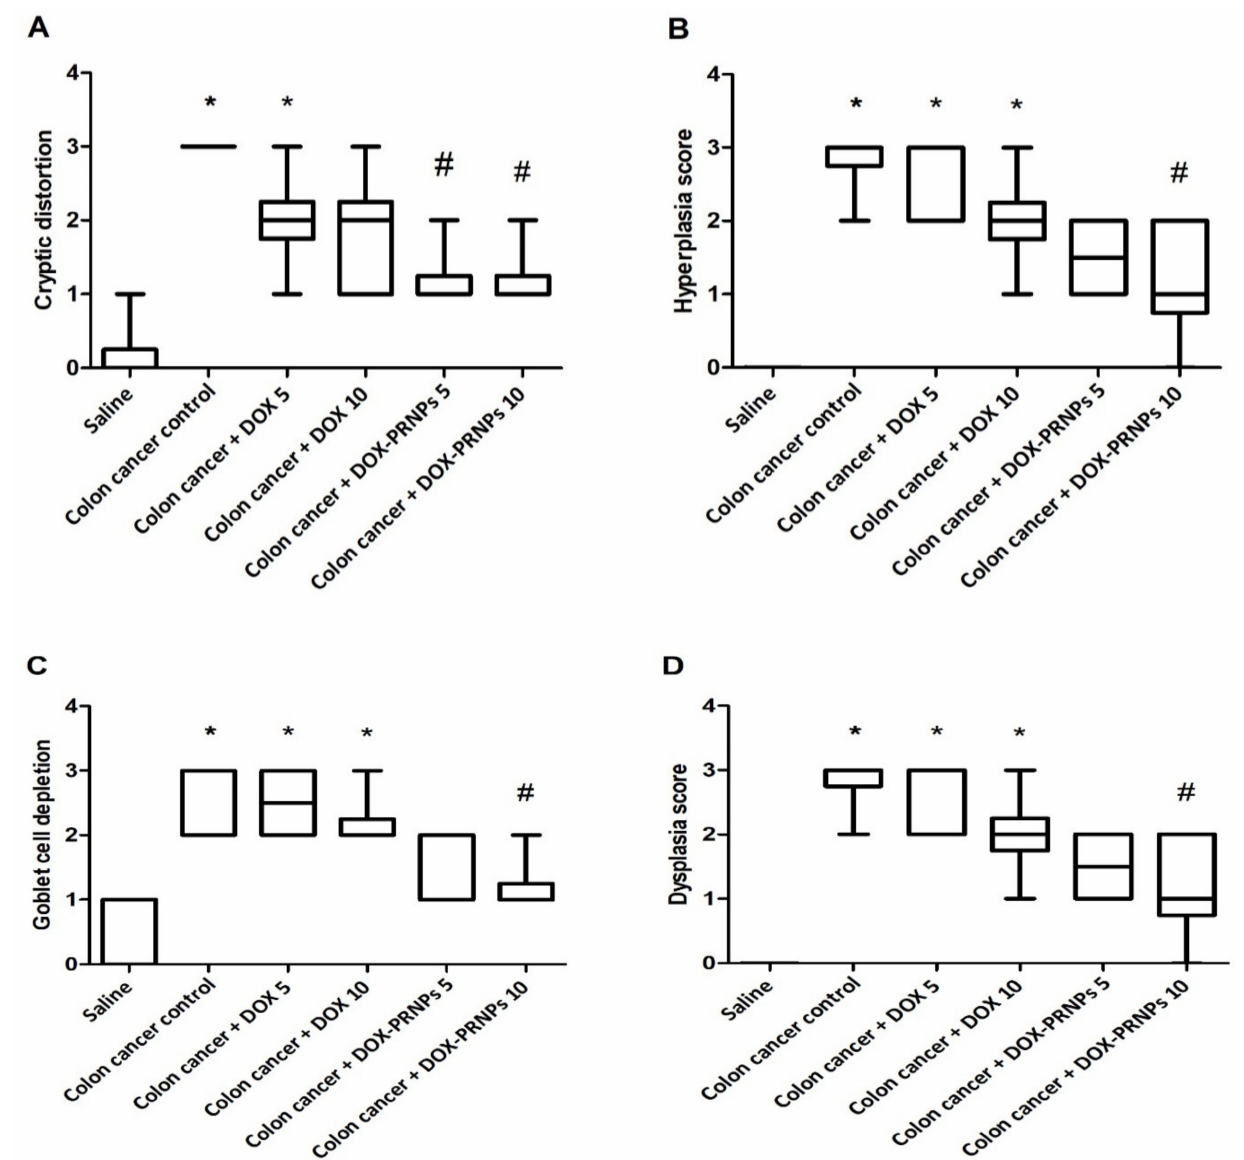
Figure 8. Histologic scores given to colon specimens stained with H&E. ( A ) Cryptic distortion, ( B ) hyperplasia, ( C ) goblet cell depletion and ( D ) dysplasia score. Scoring was performed for each item from 0–3 by an experienced pathologist. Data were analyzed by Kruskal-Wallis ANOVA and Dunn’s post hoc test for intergroup comparison at p < 0.05. *: versus saline group, #: versus colon cancer control group, p < 0.05. PRNPs: PRNP2 prepared from hydroxypropyl methyl cellulose phthalate HP55 as a